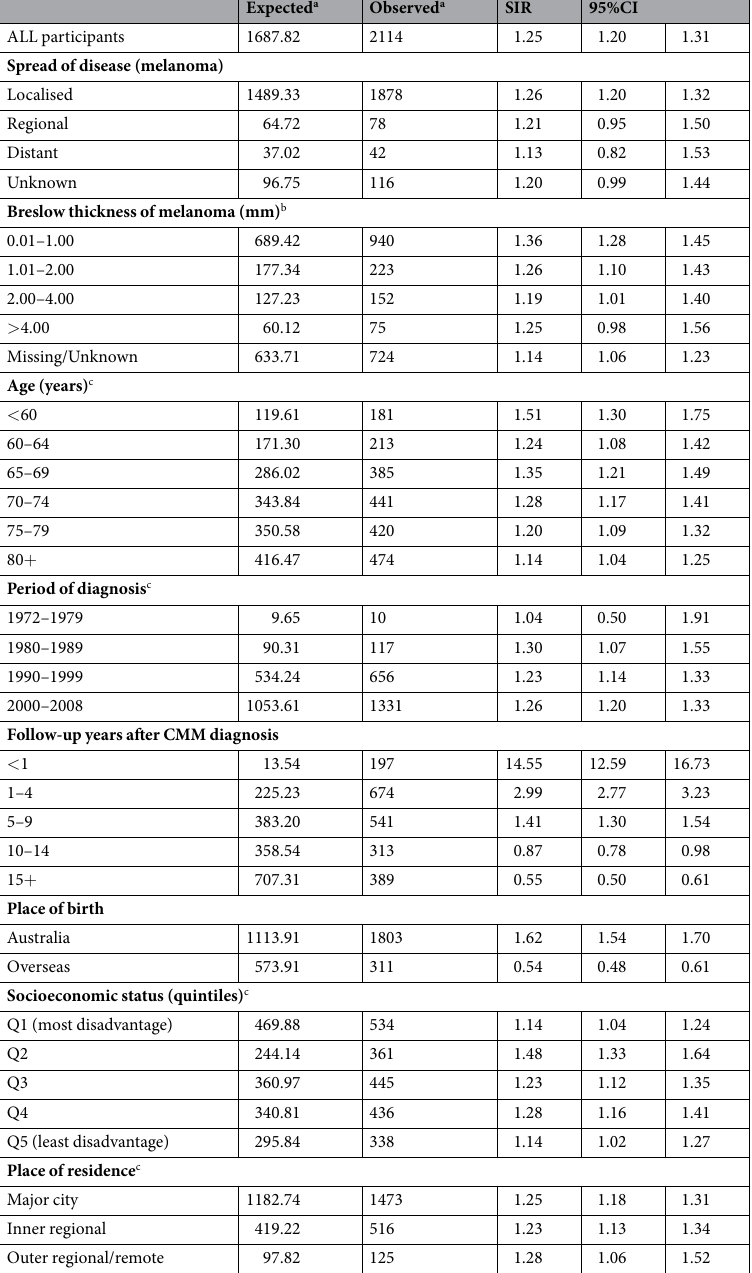
Table 1. Age standardised incidence rates (and 95% CI) for factors associated with prostate cancer risk in men previously diagnosed with cutaneous melanoma, compared to prostate cancer cases without a cutaneous melanoma, for cases diagnosed between 1972 and 2008 in the New South Wales population. a Prostate cancer cases after a melanoma diagnosis. b Categories based on the 8th edition AJCC Melanoma Staging System guidelines 39 . c Status when diagnosed with prostate